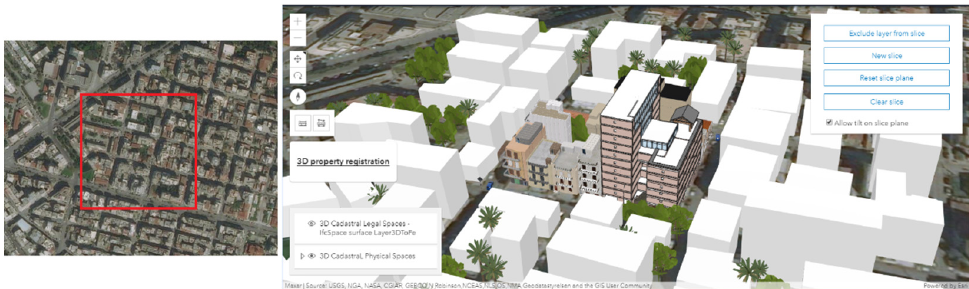
Figure 4. The aerial photo of the test area ( left ) and the 3D models of the studied and neighboring buildings ( right